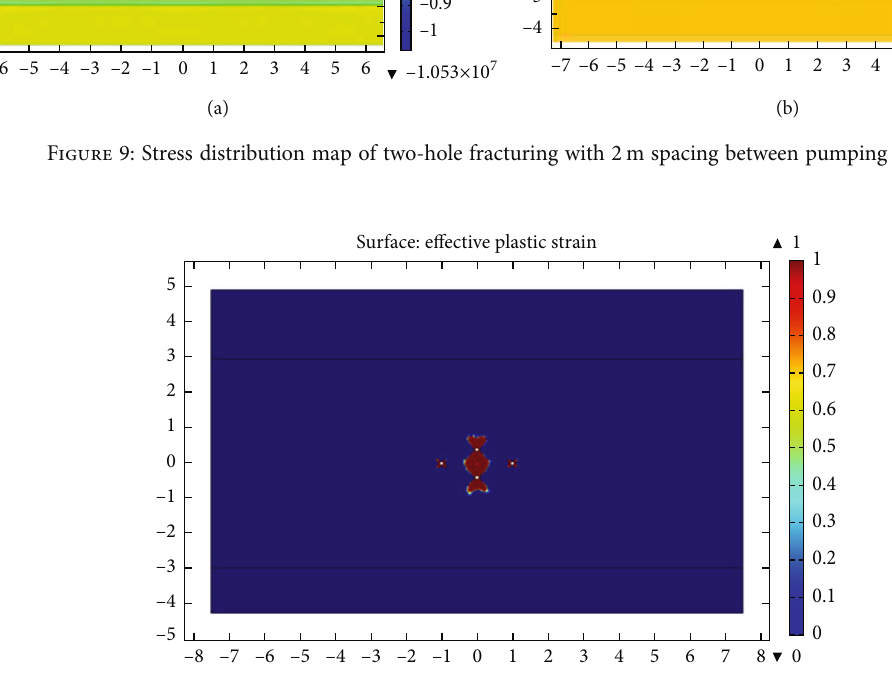
Figure 10: Distribution of plastic zone around double-hole fracturing